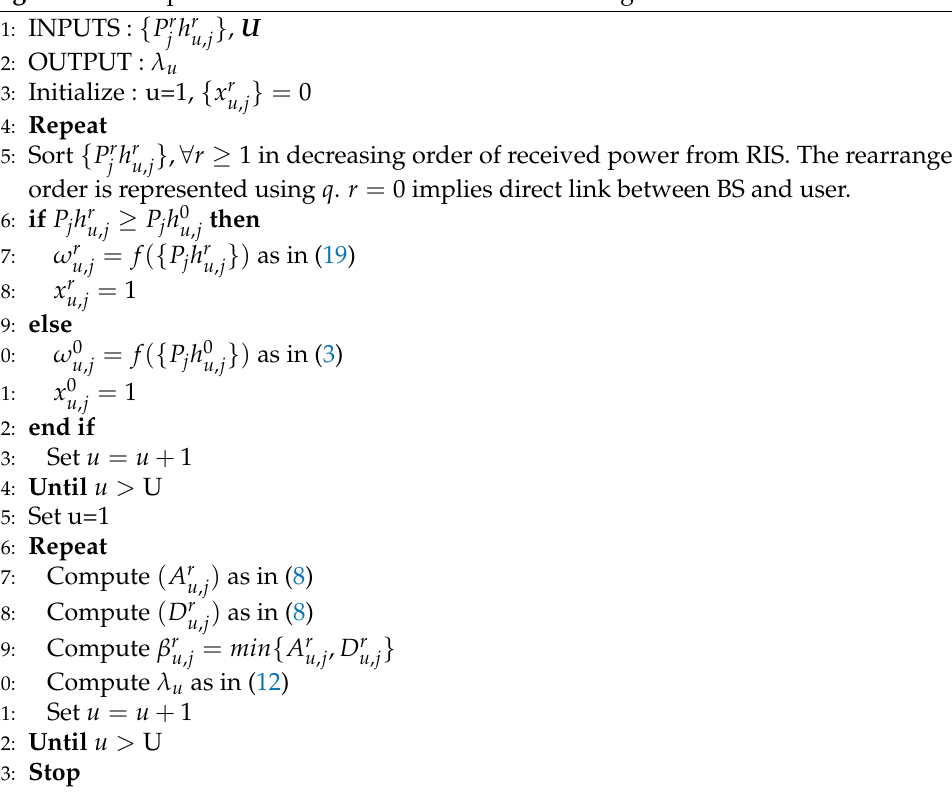
Algorithm 1 Proposed heuristic for time-based RIS